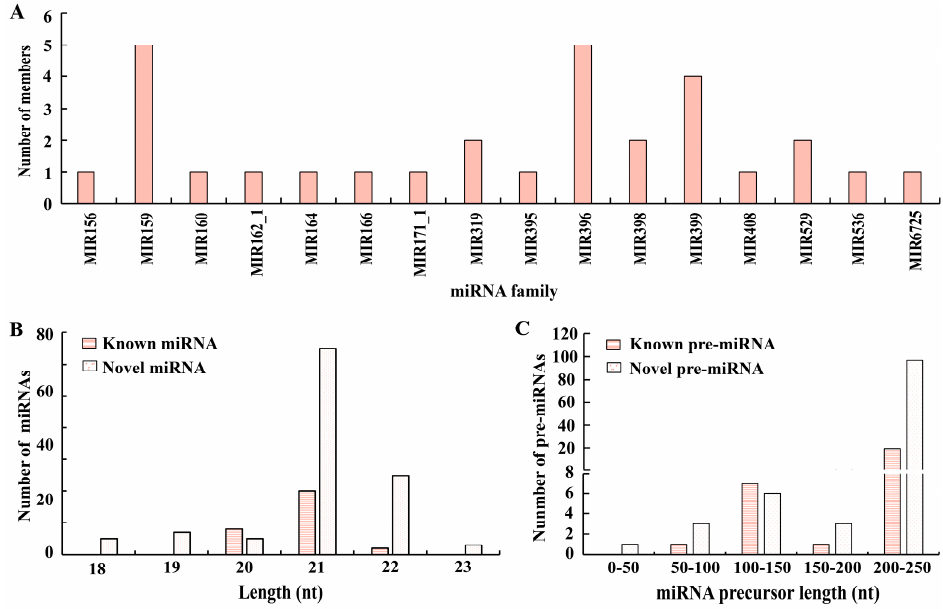
Figure 2. Characteristic of miRNA in Chinese fir. ( A ) Identification of miRNA family and its corresponding numbers from a selfed family in Chinese fir. ( B ) indicates the length distribution of known and novel miRNAs and its corresponding quantities. ( C ) indicates the length distribution of known and novel pre-miRNA and its corresponding quantities.